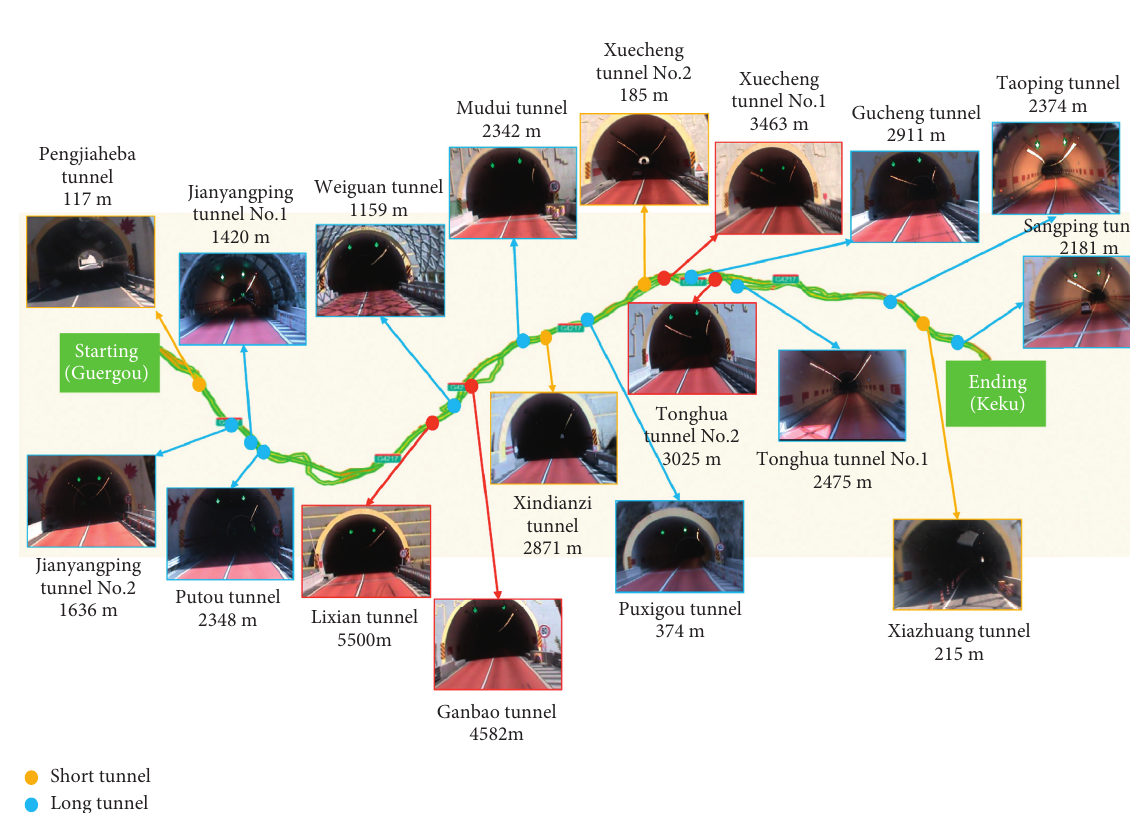
Figure 1: Tunnel distribution in the experimental